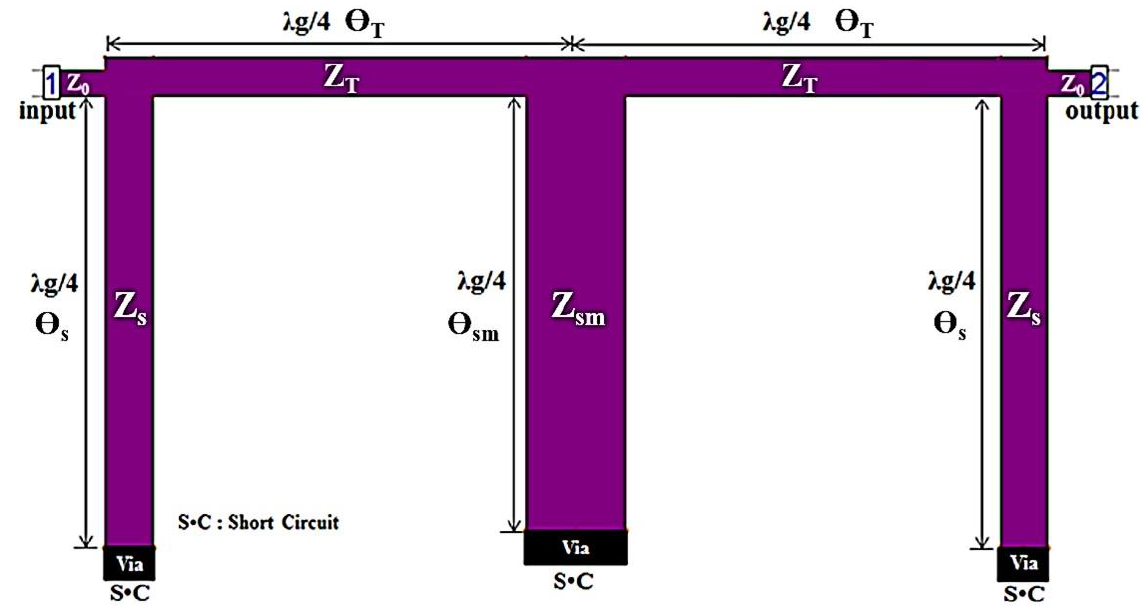
Figure 1. Conventional BPF with λ g /4 short stubs. Table 1. Calculated electrical parameters of conventional BPF.